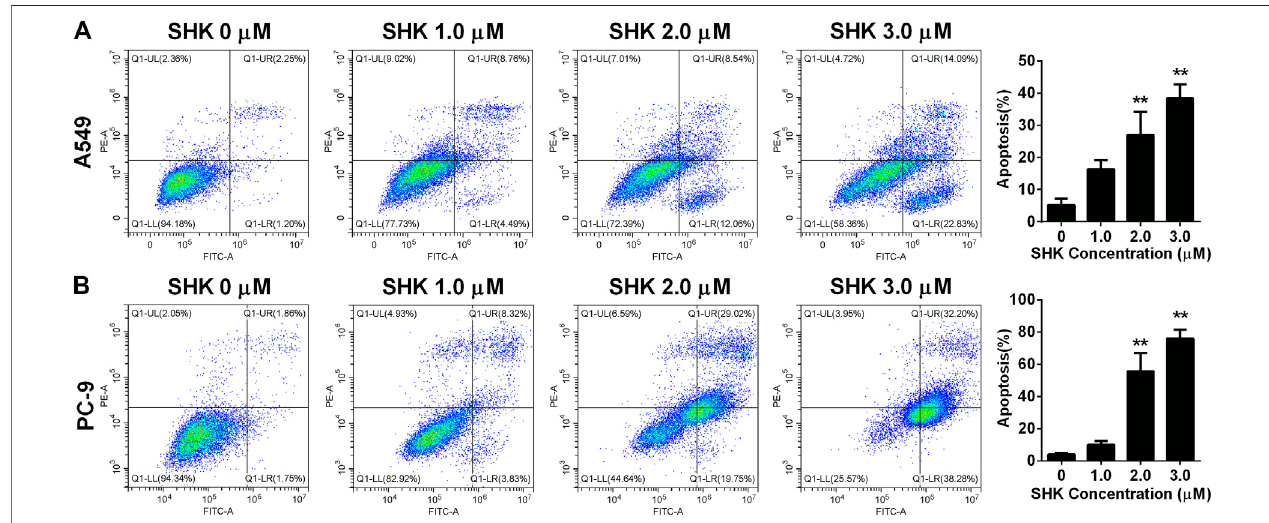
FIGURE2| Apoptosisof (A) A549cellsand (B) PC-9cellsinducedbySHK.A549cellsandPC-9cellsweretreatedbyvariousconcentrationsofSHKfor24 h;cells werestainedwithannexinV – fl uoresceinisothiocyanate/propidiumiodideandevaluatedforapoptosisby fl owcytometry.Allmeasurementswerecarriedoutintriplicates, and data are given as mean ± SD ( n (cid:2) 3). ** p < 0.01.